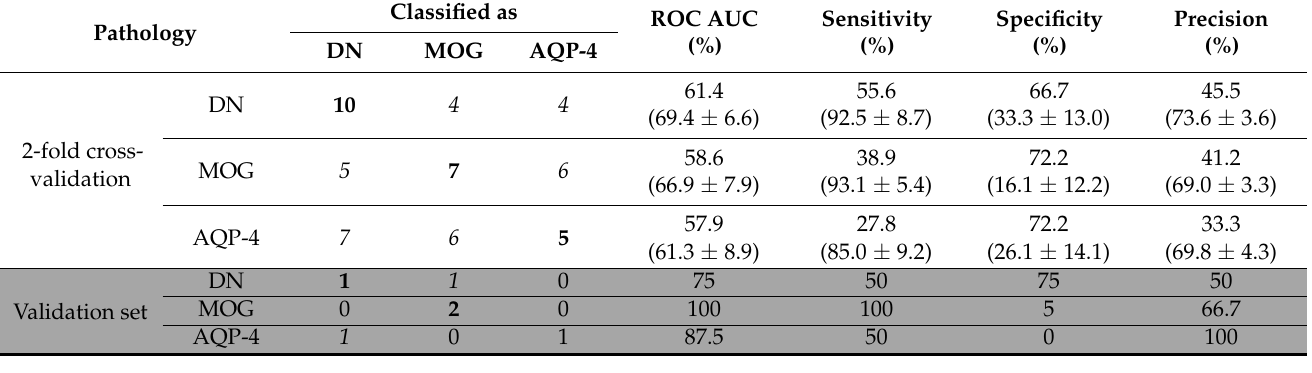
Table 2. Performances (confusion matrix, ROC AUC, sensitivity, specificity, and precision) of the random forest model based on second derivatives of FTIR spectra of the NMOSD serum samples discriminating DN, AQP-4 and MOG. The first row concerns two-fold cross-validation on the train- ing set (18 DN, 18 AQP-4 and 18 MOG). The values in parentheses correspond to a ten-iteration internal validation of the model (see Materials and Methods for details). The grey rows record the performances on the test set (2 DN, 2 AQP-4 and 2 MOG). True positives are in bold and false negatives/false positives are in italics.